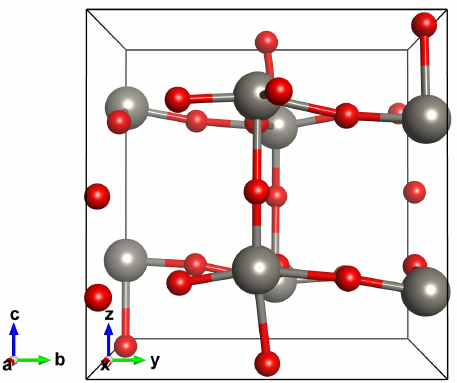
Figure 2. Atomic structure of the γ -monoclinic WO 3 . Tungsten in black and oxygen in red.